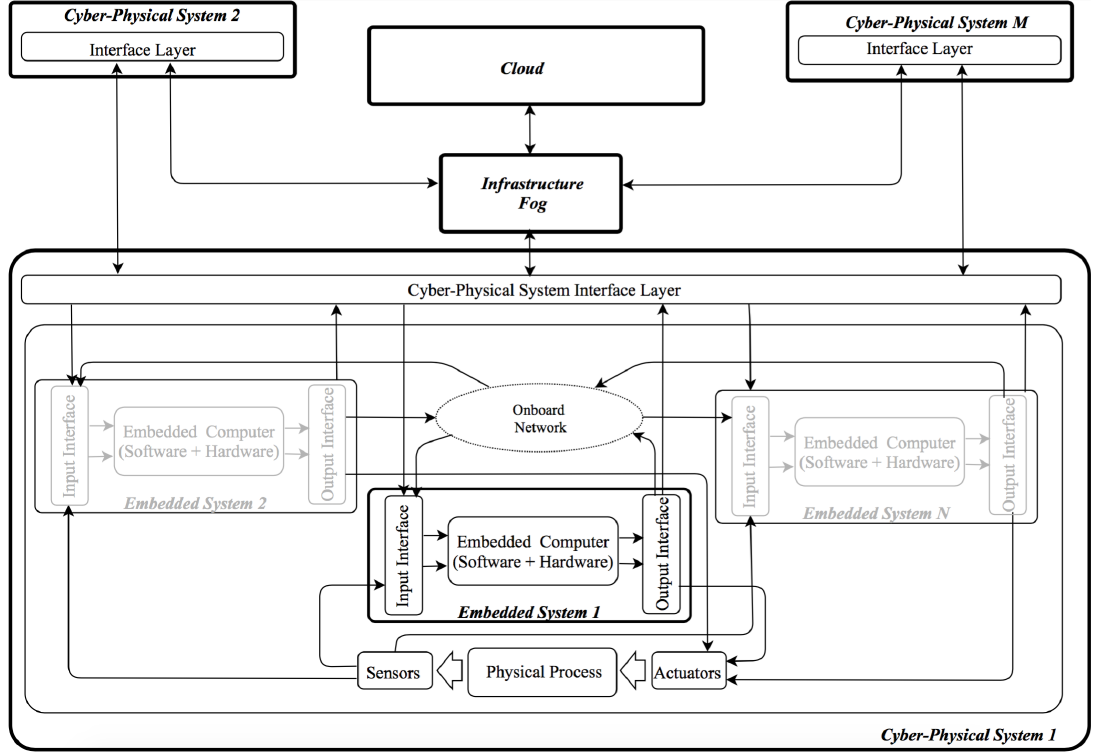
Figure 1. Defining the boundaries of embedded systems and CPSs in the CPS